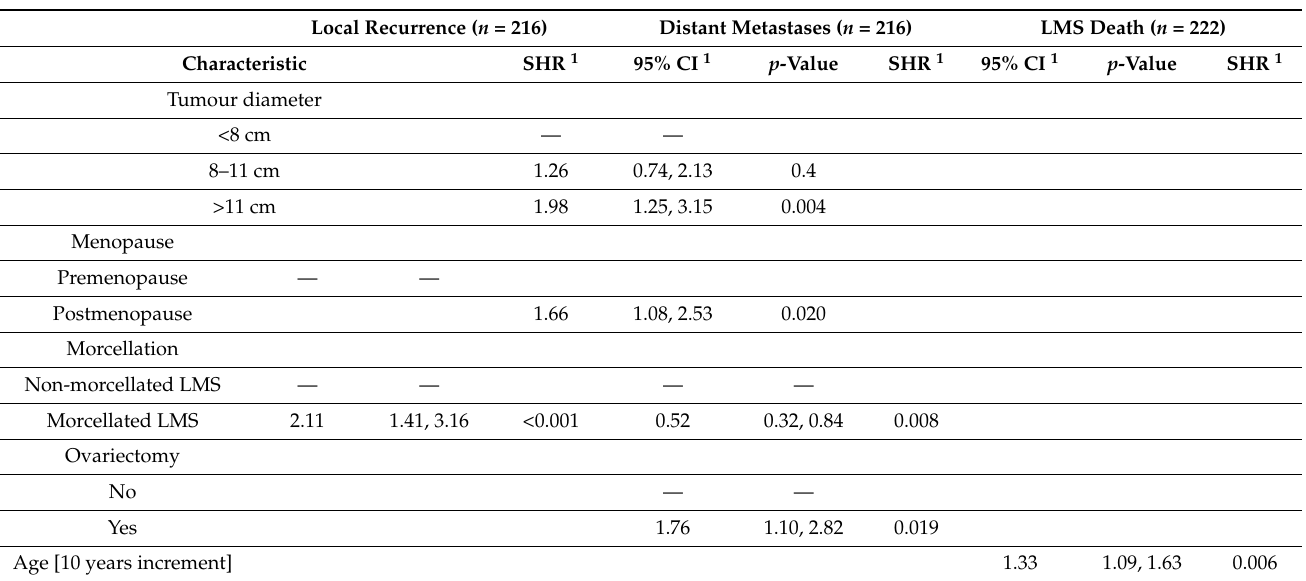
Table 3. Results of the multivariable competing risks regression of pT1 LMS after stepwise model reduction showing the subdistribution hazard ratios (SHR) for each factor with 95%-confidence intervals for each event type,